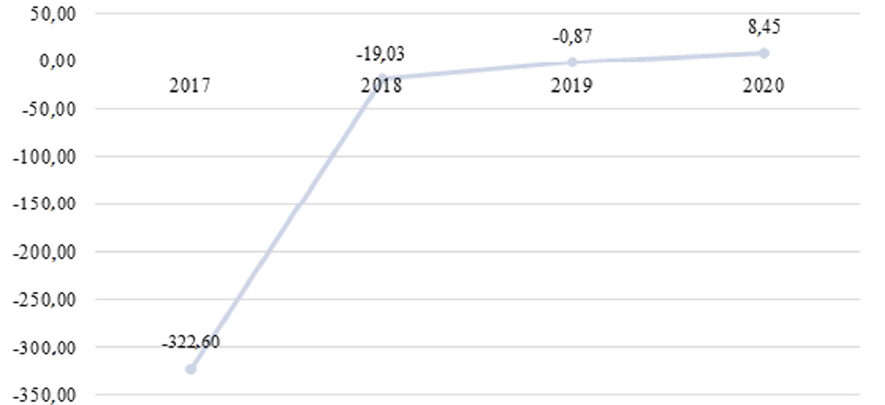
Figure 4. Overall liquidity of SMEs financed in the MAV